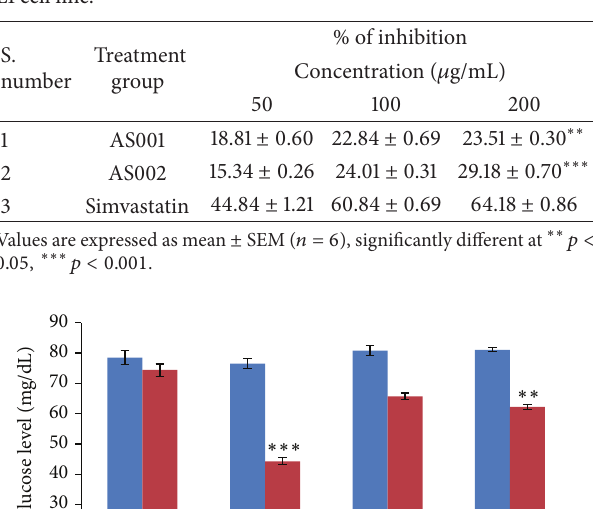
Table 1: Antiadipogenic activity of different dose of extract in 3T3- L1 cell line.